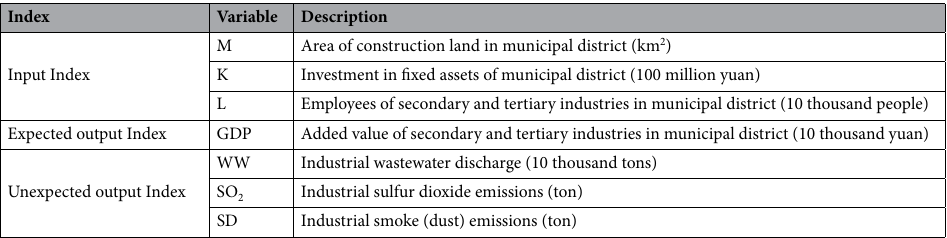
Table 1. Input and output